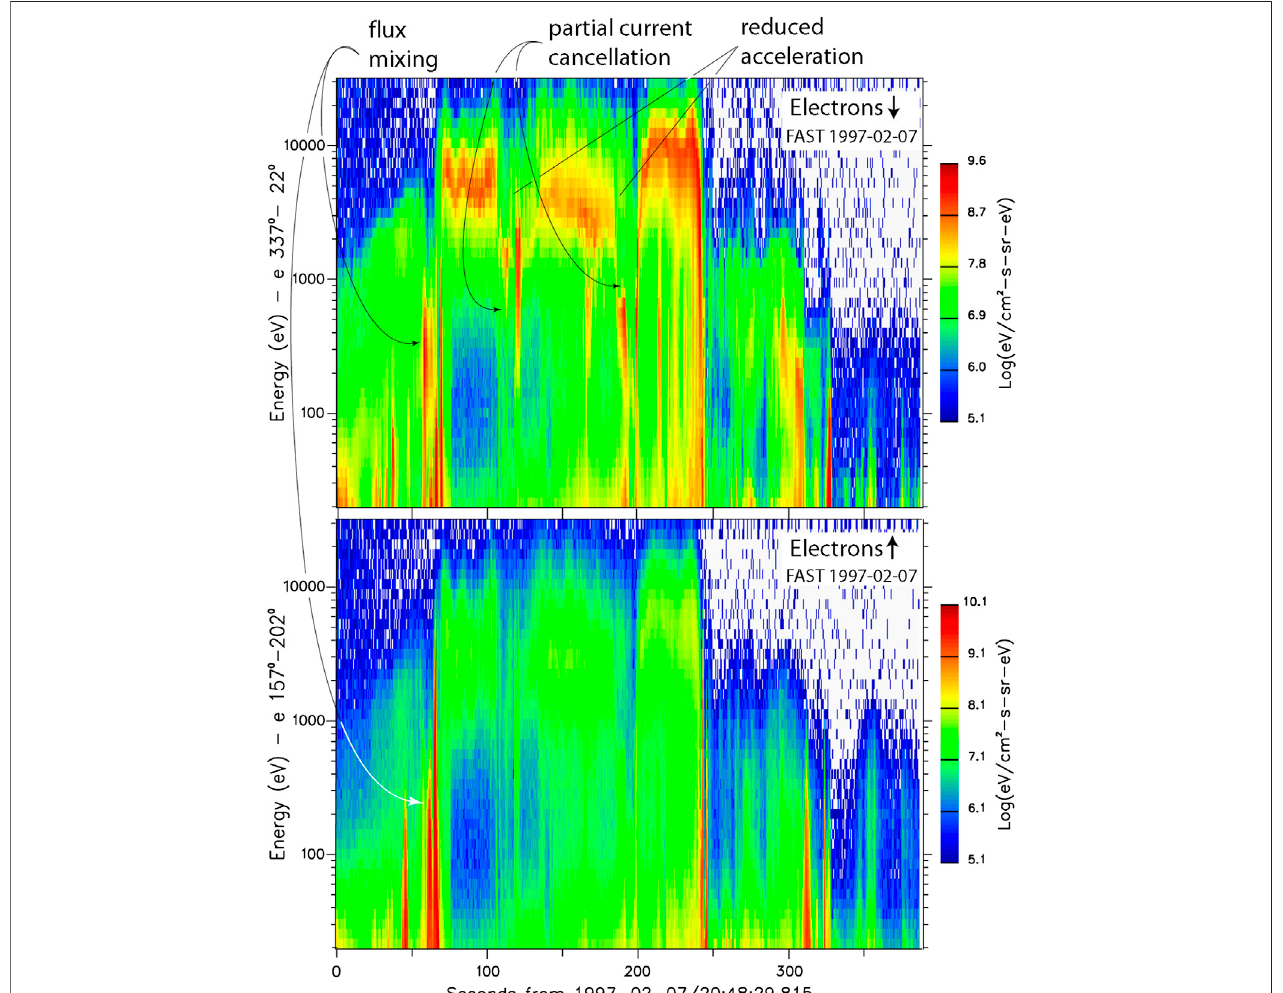
FIGURE 3 | Sequence of downward (top) and upward (bottom) auroral electron fl uxes observed by FAST on July 2, 1997 in the topside auroral region when crossing a substorm aurora (after [32]). The sequence distinguishes nicely between the intense downward electron fl uxes at energies ε e ∼ 10 keV and downward fl uxes at energies ε e < 0 . 1 keV. Upward fl uxes are con fi ned to narrow spatial regions, downward fl uxes are distributed over a much wider domain. In the transition regions between both domains one observes fl ux mixing which indicates that the current systems are not simply two dimension and also that there are many overlapping fl ux and current sources which the one-dimensional path of the spacecraft does not resolve